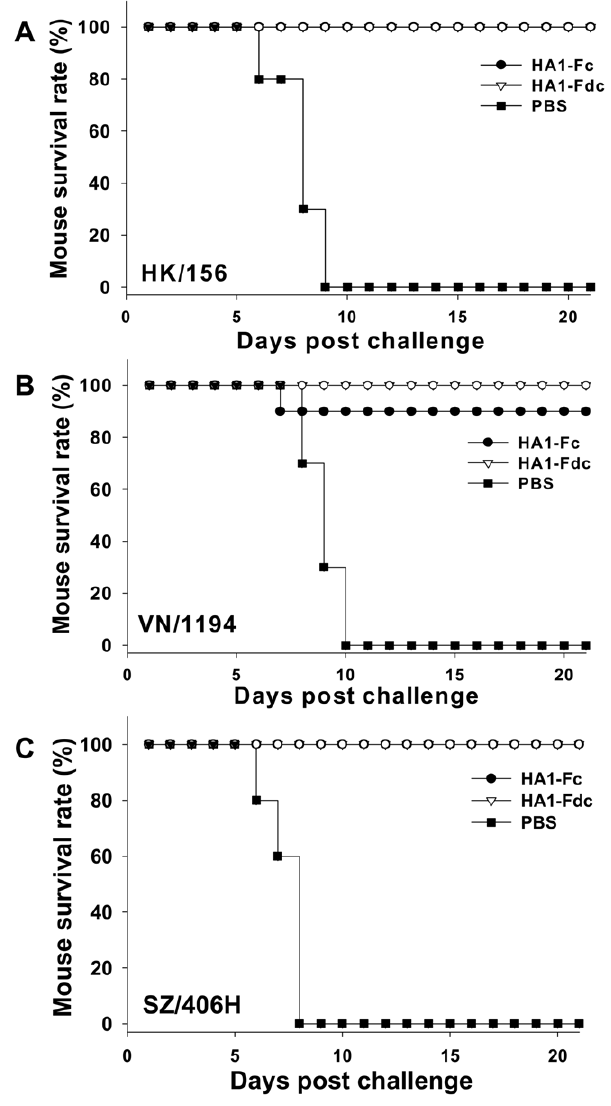
Figure 6. Cross-clade protection of HA1-Fc- or HA1-Fdc- vaccinated mice against lethal H5N1 virus challenge. HA1-Fc- and HA1-Fdc-vaccinated mice were challenged with 10 LD 50 of three clades (clade 0: HK/156, clade 1: VN/1194, and clade 2.3.4: SZ/406H) of H5N1 virus. PBS was used as the negative control. Groups of 10 mice were observed for survival for 21 days post-virus challenge, and corresponding survival rates were calculated. Survival rate (%) of mice challenged with HK/156 (A), VN/1194 (B), and SZ/406H (C) H5N1 virus was shown.